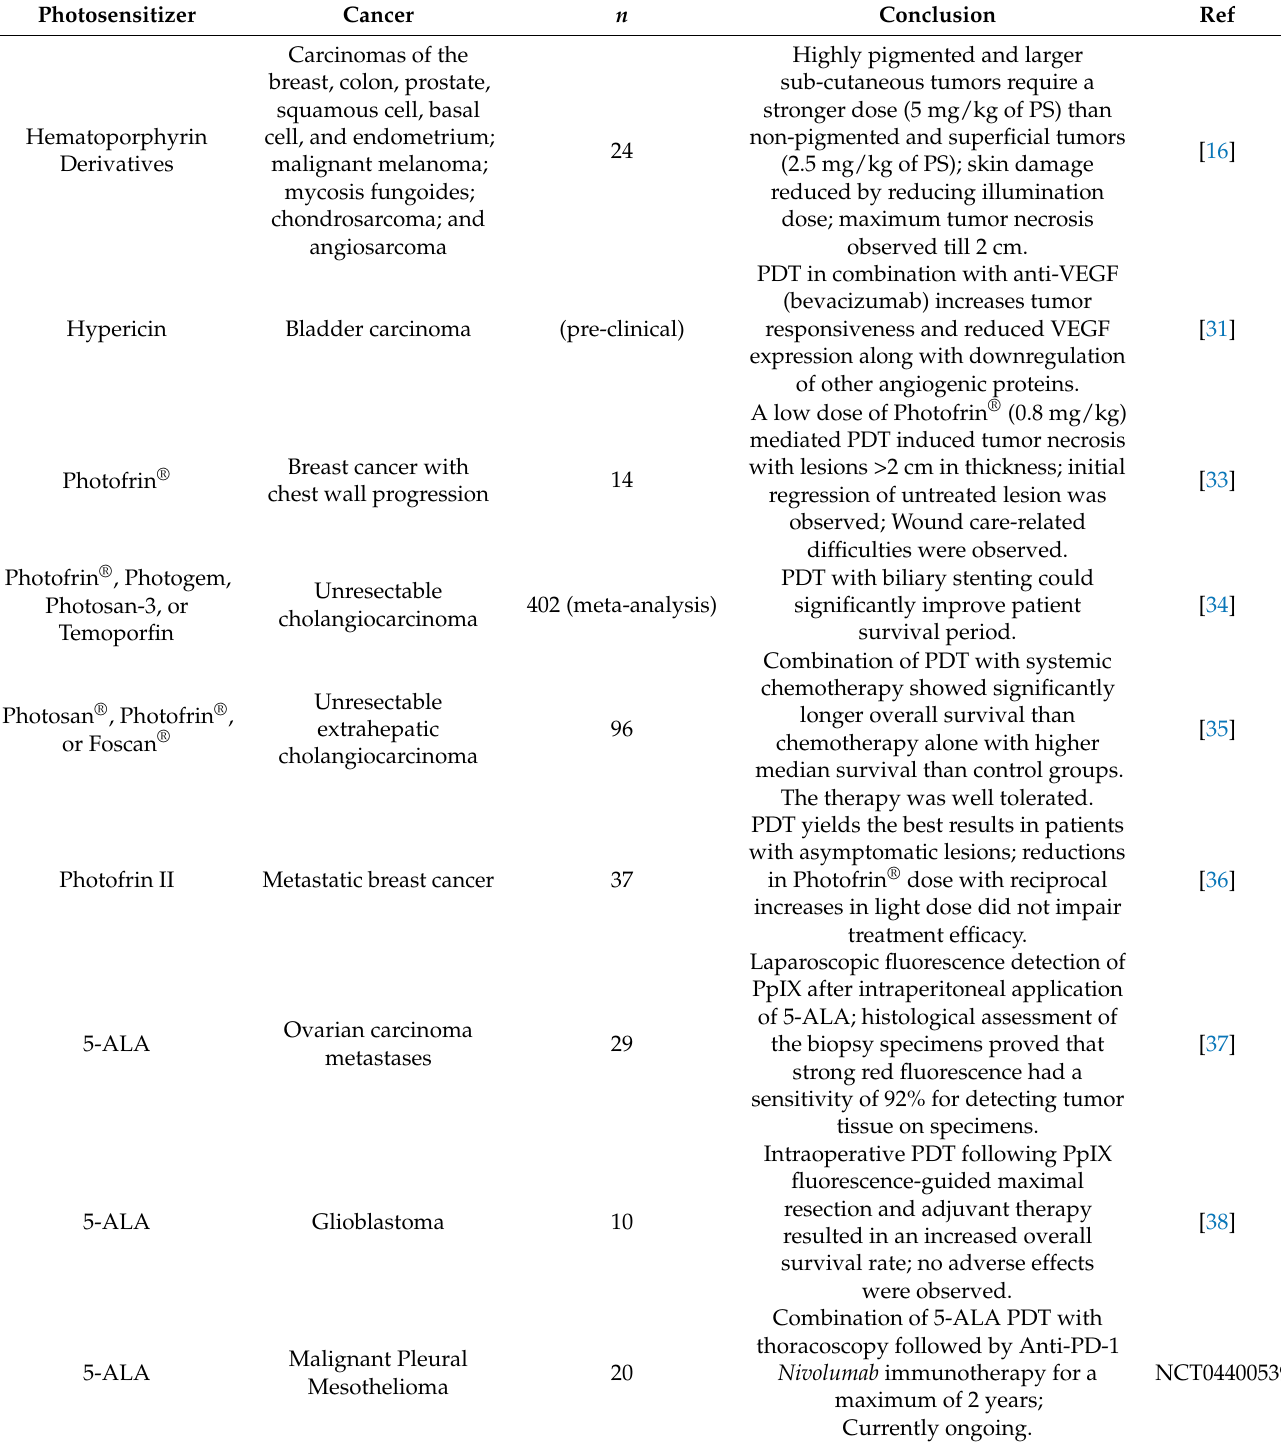
Table 1. List of key clinical and pre-clinical studies using Photodynamic Therapy for the treatment of various cancers. PS: Photosensitizer; VEGF: Vascular Endothelial Growth Factor; PDT: Photodynamic Therapy; 5-ALA: 5-Aminolevulinic Acid; PpIX: Protoporphyrin